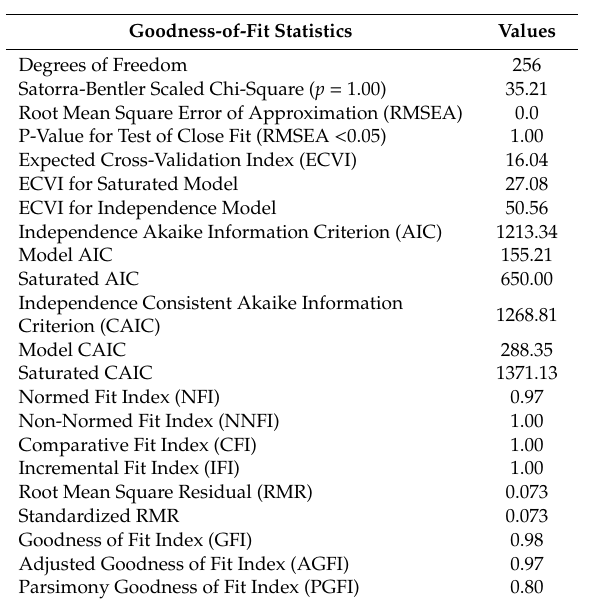
Table 2. Goodness-of-fit statistics for the Five Factors Model of Family Stress and Family Quality of Life (FQOL)